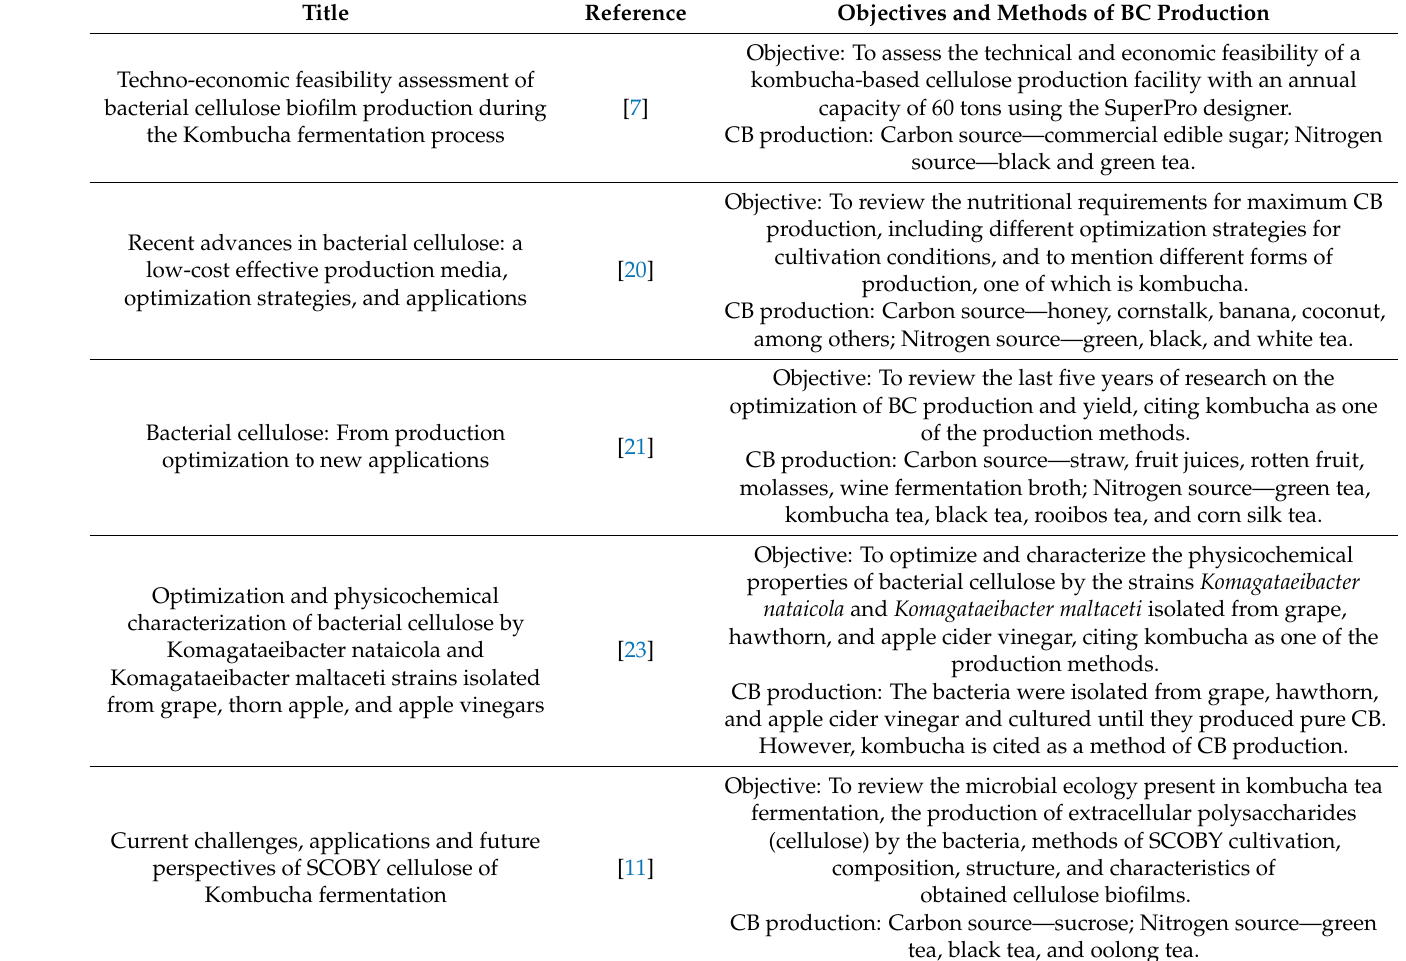
Table 2. Research, objectives, and modes of bacterial cellulose